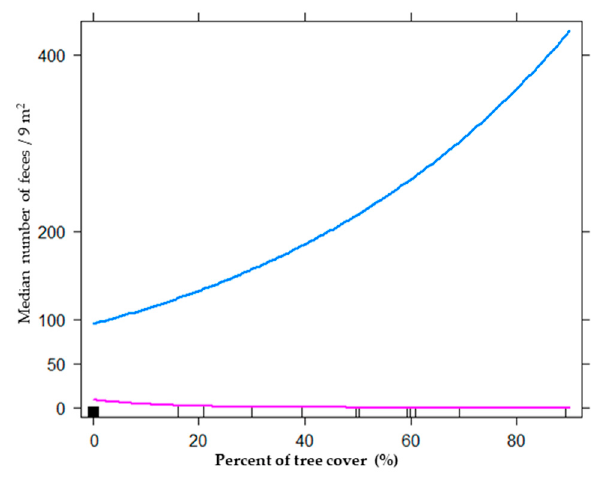
Figure 4. Interaction of tourism activity and tree cover with habitat use of maras ( Dolichotis patagonum ), measured as median number of mara feces by quadrat (3 m × 3 m), as a response variable, of models for biological plant forms and floristic composition levels: (a) blue line, near tourist circuit (high tourist activity), (b) pink line, distant tourist circuit (low tourist activity).